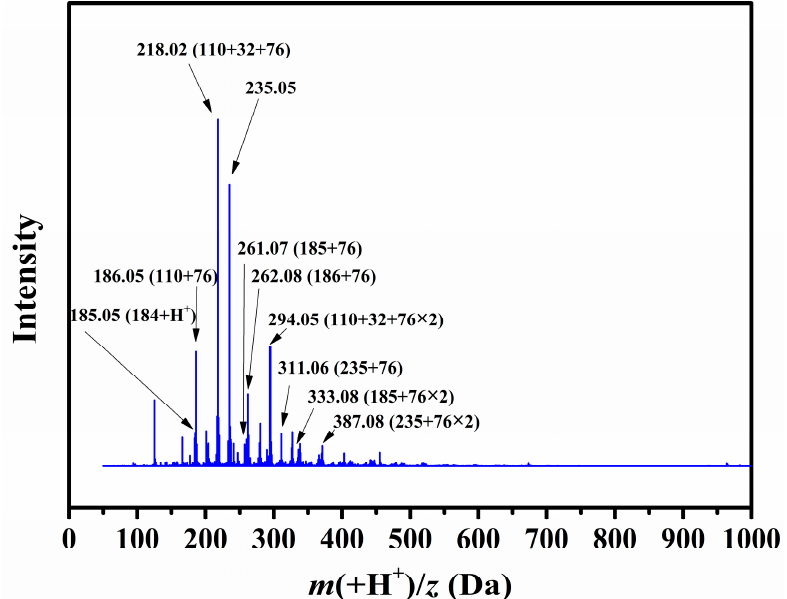
Figure 6. Q-TOF spectra of sodium thiophenolates at selected temperatures (APCI negative mode).